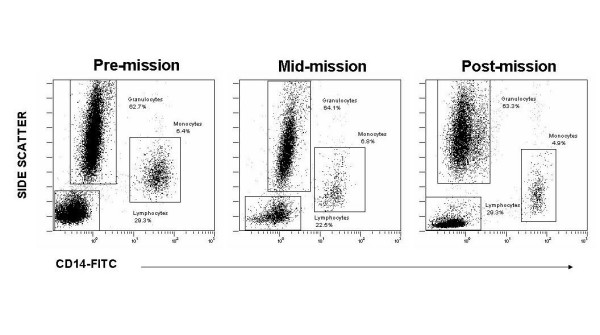
Representative flow cytometry scatter plots demonstrated the analytical integrity of the field-processed mid-mission samples. For flow cytometry analysis, whole blood was preserved with a non-cross linking preservative. This reagent was found to inhibit cellular auto fluorescence, as well as preserve antigenic structure of both extracellular as well as intracellular (cytokine) molecules. CD14 vs. side scatter plots allowing enumeration of granulocyte, monocyte and lymphocyte subsets are presented derived from a CD45+ gate to eliminate artifactual debris.